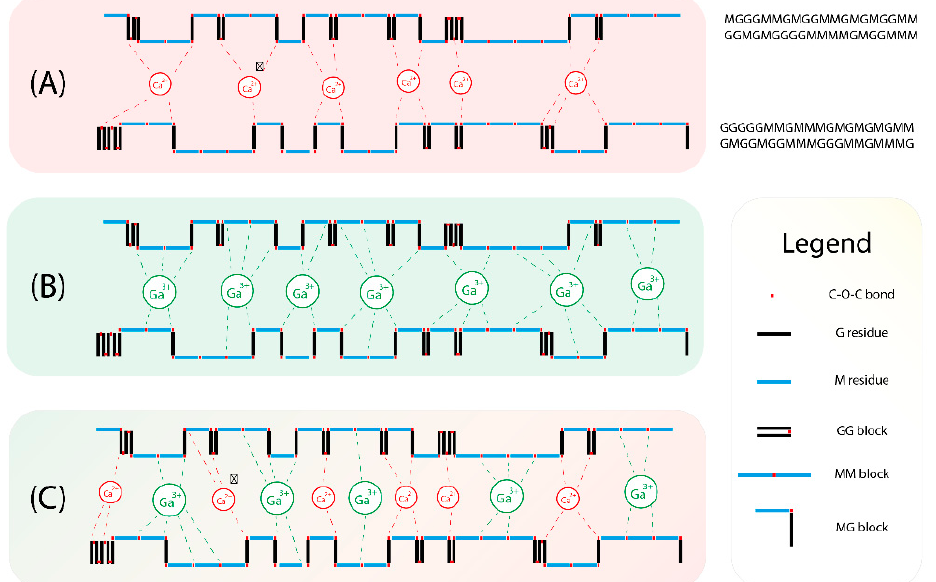
Figure 4. Graphic demonstration of the two-dimensional theoretical binding nature of Ca 2+ and Ga 3+